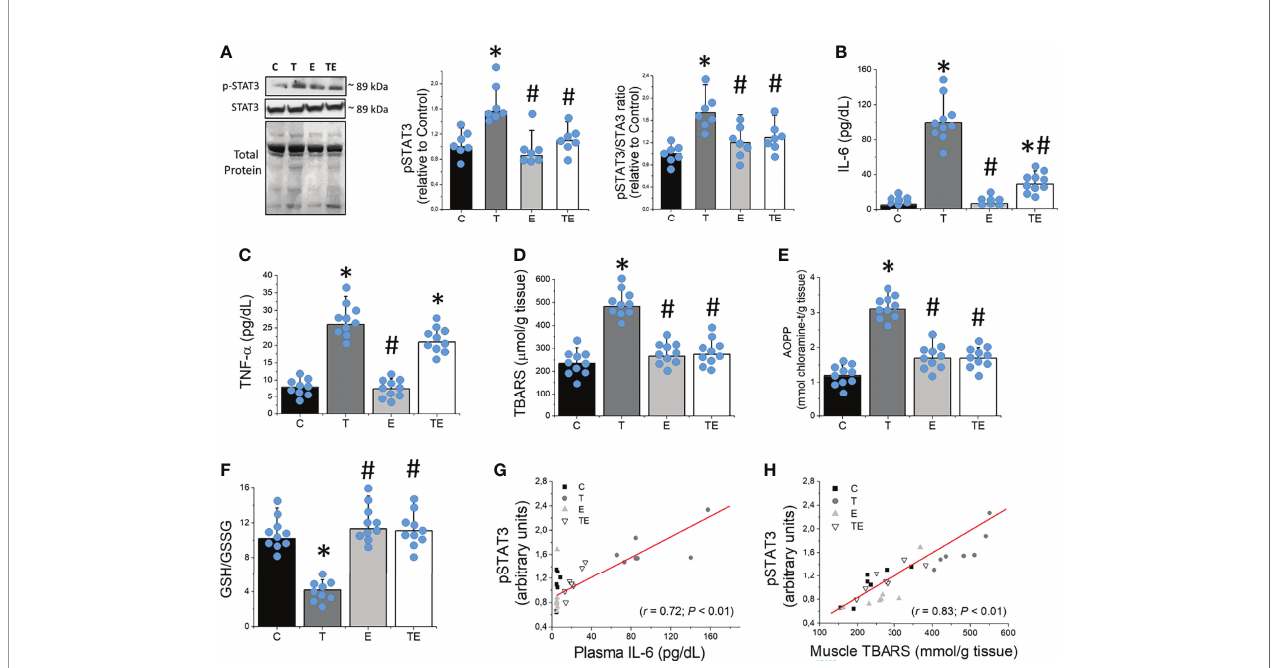
FIGURE 4 | Resistance exercise prevents tumor growth-induced STAT3 phosphorylation associated to elevated IL-6 and skeletal muscle oxidative stress. (A) Skeletal muscle protein levels of STAT3 (n = 7), (B) plasmatic concentration of IL-6 (n = 10) and (C) TNF- a (n = 10), (D) skeletal muscle concentration of TBARS (n = 10), (E) AOPP (n = 10) and (F) GSH/GSSG ratio (n = 10). (G) Association between skeletal muscle protein levels of STAT3 and IL-6 plasma concentration and (H) skeletal muscle TBARS concentration (n = 7) for groups control, tumor-bearing, exercised and tumor-bearing exercised groups. Results are mean ± standard deviation. * p < .05 , compared with control; # p < .05 , compared with Tumor-bearing group (by ANOVA two-way followed by Tukey post-hoc test). AOPP, advanced oxidation protein products; C, control group; E, exercised; GSH, Glutathione; GSSG, Glutathione disul fi de; pSTAT-3, Signal transducers of transcription- phosphorylated; STAT-3, Signal transducers of transcription; T, tumor-bearing; TBARS, Thiobarbituric acid reactive substances; TE, tumor-bearing exercised; TNF- a , tumor necrosis